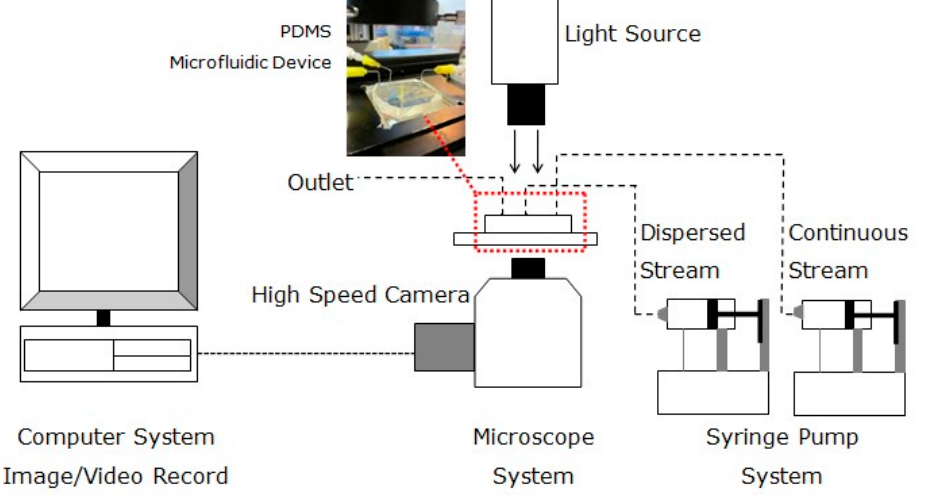
Figure 2. Experimental set up diagram depicting the microscope system utilized, connected to a high speed camera that enabled recording of the observed behaviour. Two syringe pumps were employed to drive the flows.